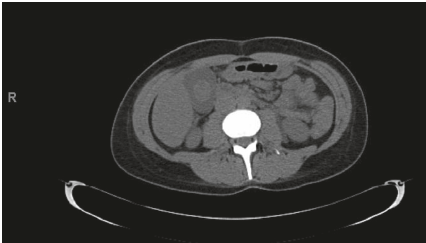
Figure 1: CT abdomen and pelvis without contrast demonstrating mild perihepatic ascites, diffuse low-attenuation of the liver likely due to active hepatocellular disease. Diffusely thickened gallbladder wall as demonstrated on abdominal ultrasound. Additional CT findings include a moderate amount of free fluid in the pelvis and a small right-sided pleural effusion. No obstructing renal calculus